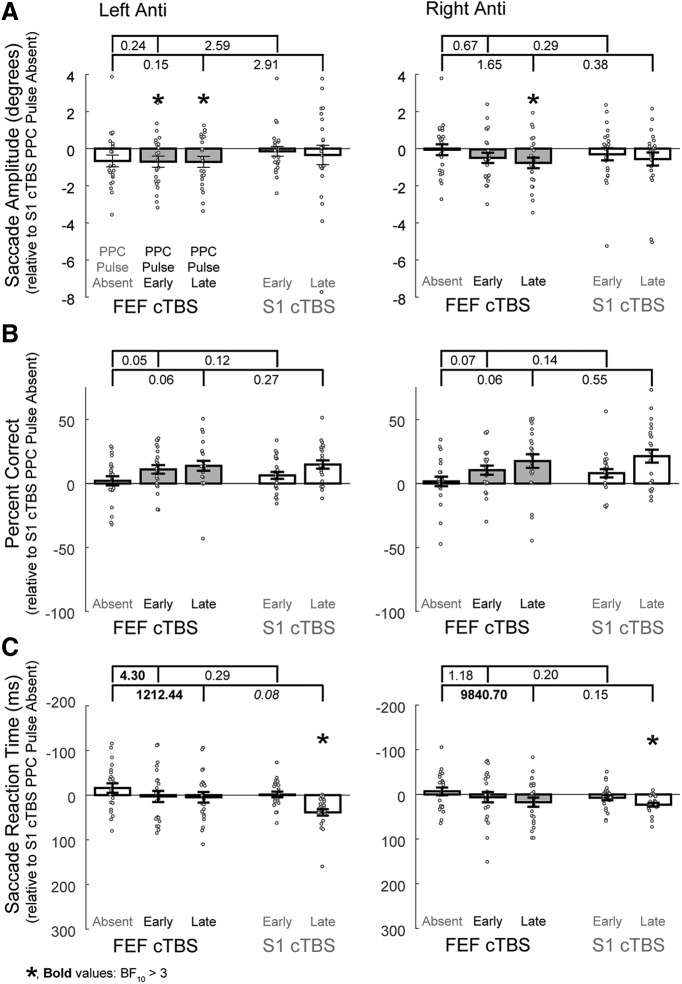
Effects on left and right anti-saccades when the double perturbation involving FEF cTBS and PPC TMS are compared with the single perturbation conditions for A, Saccade amplitudes, B, Percentage correct directions, and C, Saccade reaction times. All data are normalized to the cTBS control condition (cTBS to S1, no PPC pulses). Error bars represent SEM across subjects (N = 23), and dark gray represents the double perturbation conditions. Values between brackets indicate the Bayes factor evidence for the alternative hypothesis that the combined effects from the double perturbation resulted in a greater impairment (more negative values, note the y-axis is reversed for saccade reaction times) compared with the effects of the single perturbations. Values >3 provide substantial evidence for the alternative hypothesis that the combined effects resulted in a greater impairment than the single perturbation effects. Asterisks show the results from Bayesian one-sample t tests for evidence that the values are <0 for amplitude and percentage correct, or >0 for reaction time, where BF10 > 3.